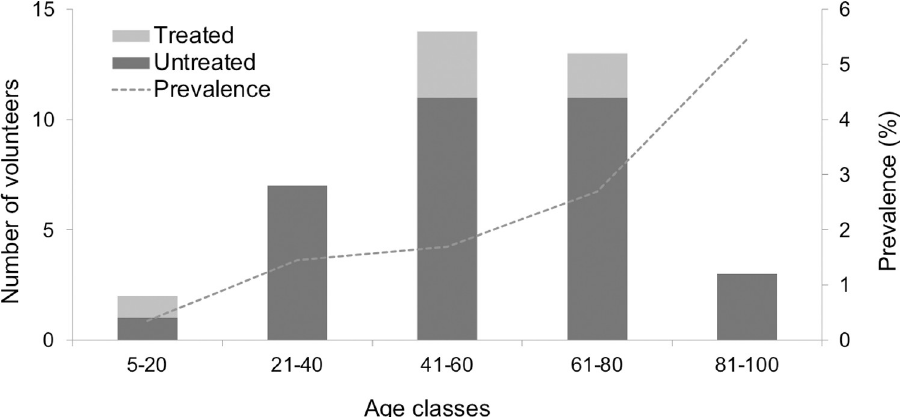
Fig 4. Distribution of abdominal cystic echinococcosis (CE) by age classes and prevalence. Number of volunteers with untreated abdominal CE (including new diagnoses and known but untreated infection) and volunteers with abdominal CE cysts on US who reported previous treatment for an abdominal CE cyst in any body location (bars; left Y axis) and overall prevalence of abdominal CE in the screened population (dotted line; right Y axis) according to age class (X axis). Age classes are expressed in